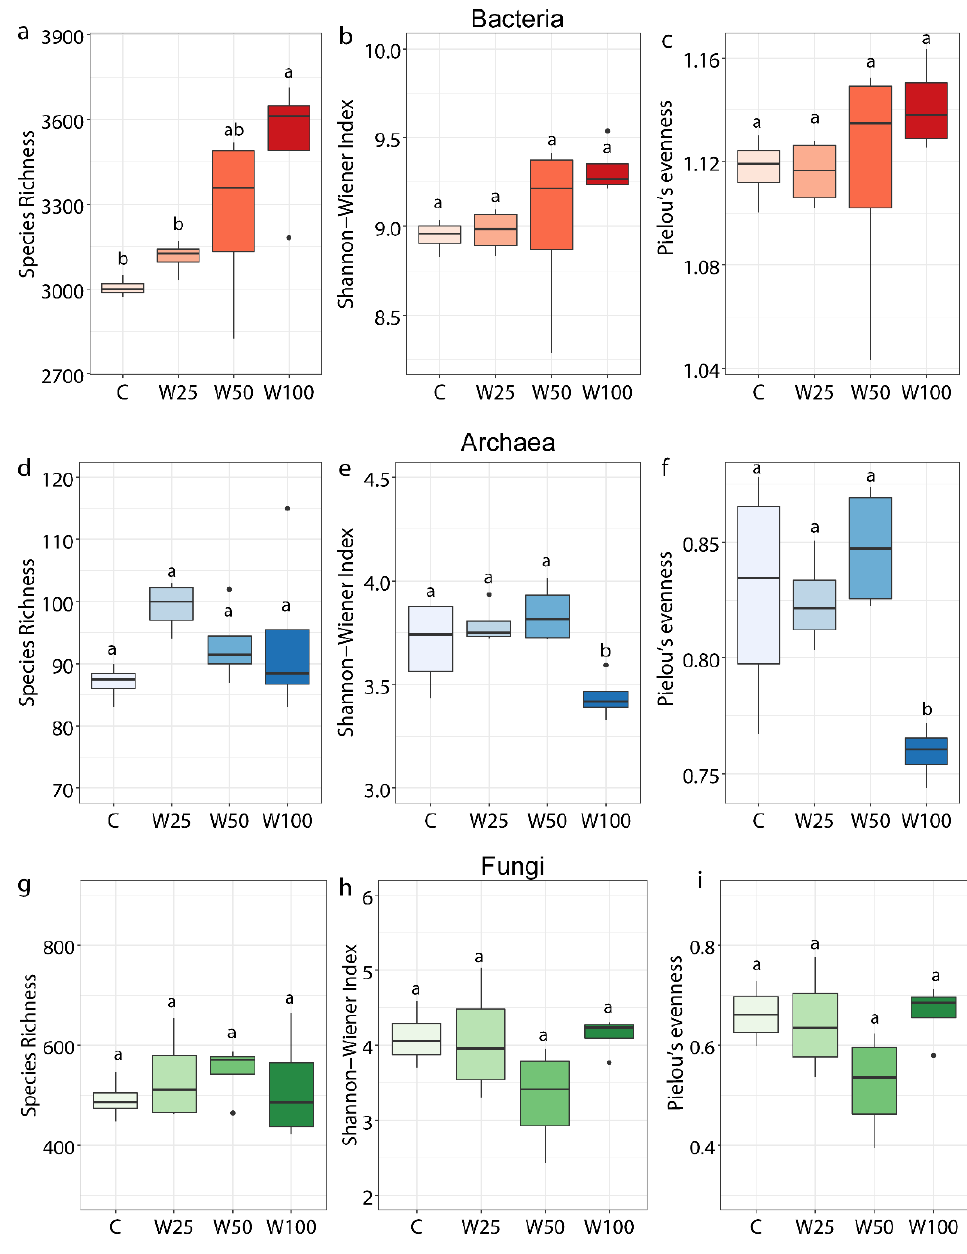
Figure 1. Alpha-diversity of bacterial ( a – c ), archaeal ( d – f ), and fungal ( g – i ) taxonomic communities in different water addition treatments. Boxes represent values from the lower 1/4 quantile to the upper 1/4 quantile. The tops and bottoms of boxes represent the upper 95% CI and the lower 95% CI, respectively. Outliers are drawn as black solid circles above or below boxes. Lowercase letters depict significant differences across treatments. C = ambient precipitation; W25 = ambient precipitation +25% of local annual mean precipitation; W50 = ambient precipitation + 50% of local annual mean precipitation; W100 = ambient precipitation +100% of local annual mean precipita- tion.